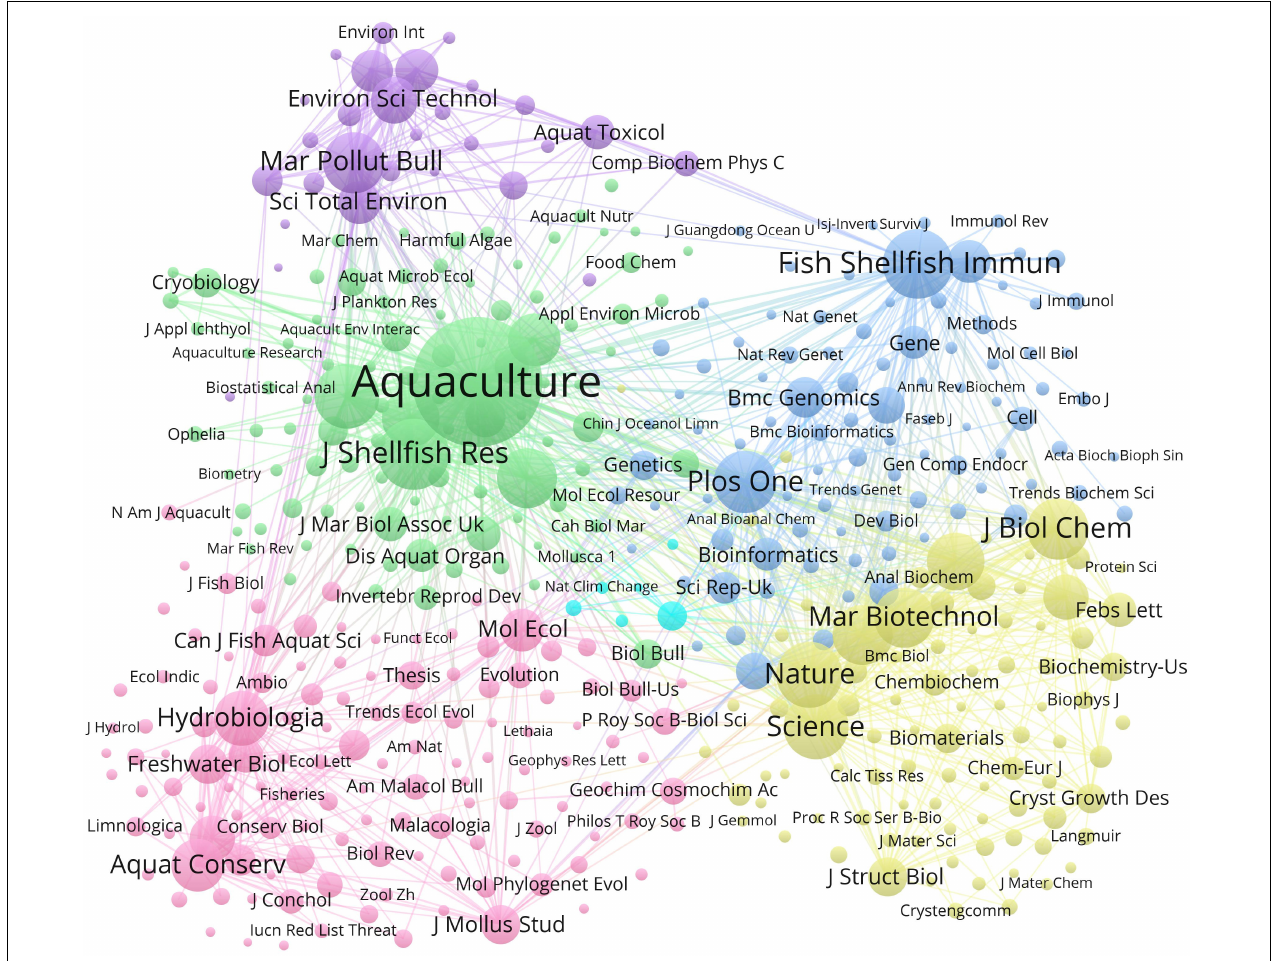
FIGURE 6 | Bibliometric map of the studies of pearl bivalve mollusks as the theme. The size of the dot is proportional to the frequency that a certain co-citation appears in the analyzed articles. A line between two dots means that these two co-citations appeared in the same article. The positive correlation between the thicker line and the higher frequency indicated that the two co-citations appeared continually in the same